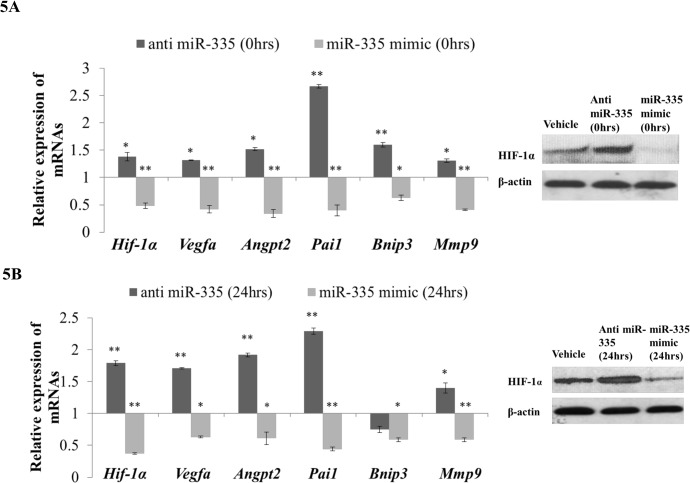
Analyses of Hif-1α and its downstream genes expression in eMCAo rats injected with anti miR-335 and miR-335 mimic in the early and late time of cerebral ischemia.(A) Hif-1α mRNA expression significantly decreased in miR-335 mimic injection samples (p value < 0.01) in early time of cerebral ischemia whereas it significantly increased upon administration of anti miR-335. HIF-1α protein was measured by Western blot and showed a similar expression pattern as Hif-1α mRNA. Angpt2, Bnip3, Mmp9, Pai1 and Vegfa mRNA expressions were significantly downregulated in the miR-335 mimic injection samples whereas displayed opposite expression pattern in anti miR-335 injection samples. (B) In the late time of cerebral ischemia (24 hrs after eMCAo), the expression of Hif-1α and its downstream genes significantly decreased in miR-335 mimic injection samples (p value < 0.01) whereas administration of anti miR-335 significantly increased the Hif-1α, Angpt2, Mmp9, Pai1 and Vegfa expression. HIF-1α protein expression was measured by Western blot and displayed the similar expression pattern as Hif-1α mRNA. Relative expression (2-ΔΔCt) was calculated based on vehicle controls as calibrator and 18S as endogenous control. *p value < 0.05; **p value < 0.01. Each gene was measured 2 times by realtime PCR in triplicates.